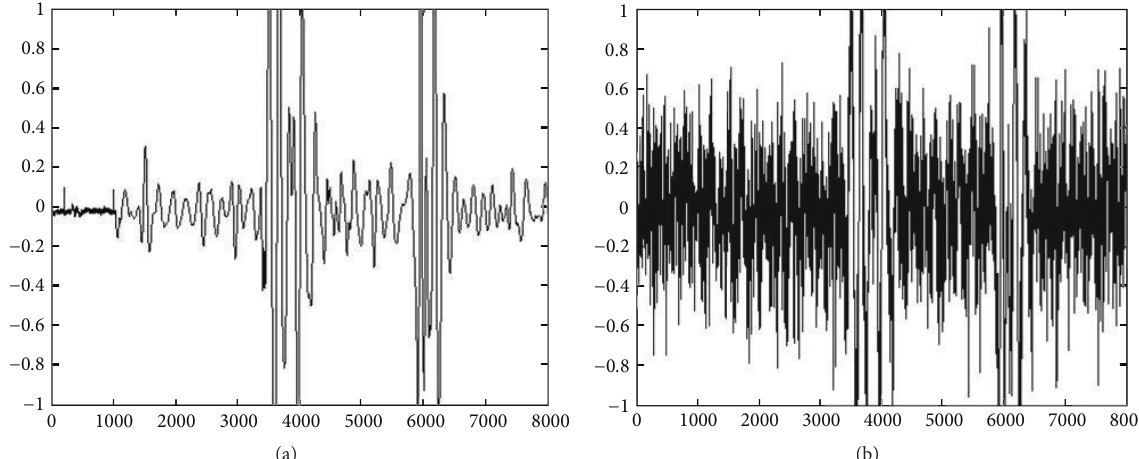
Figure 2: Wavelet thresholding.